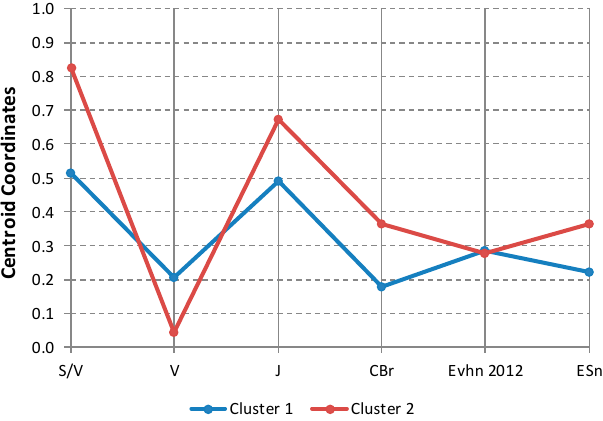
Figure 11. Normalized coordinates of the centroids of the two clusters.